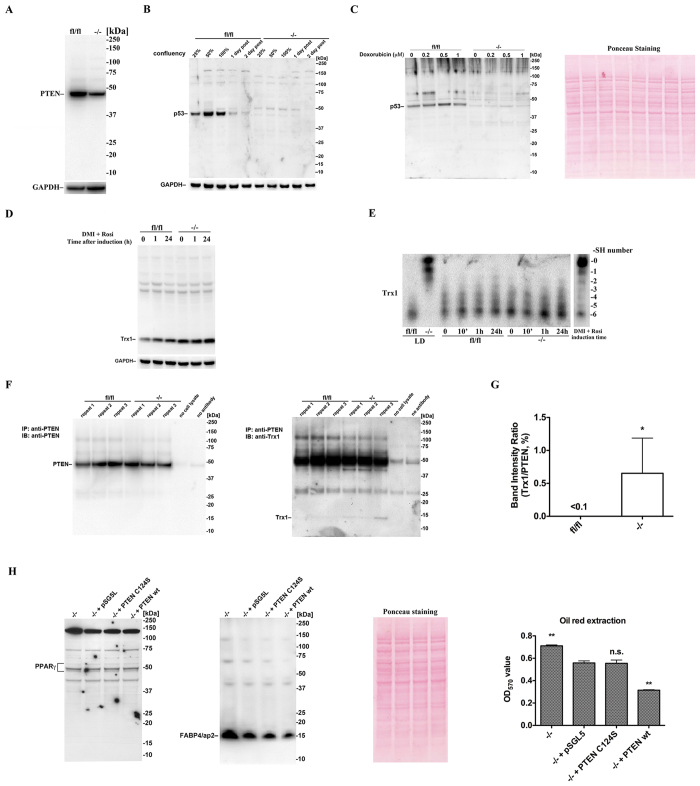
Attenuated cellular PTEN activity contributes to insulin sensitization and adipogenesis in Txnrd1−/− MEFs.(A) Lysates of Txnrd1fl/fl and Txnrd1−/− MEFs were immunoblotted with an antibody against PTEN, using GAPDH as loading control. (B) Txnrd1fl/fl and Txnrd1−/− MEFs were cultured into different stages of confluency, and lysates were immunoblotted with an antibody against p53, using GAPDH as loading control. (C) Txnrd1fl/fl and Txnrd1−/− MEFs were cultured to 100% confluency and then treated 24 h with doxorubicin as indicated. Lysates were immunoblotted with an antibody against p53 using Ponceau S staining as loading control. (D) Txnrd1fl/fl and Txnrd1−/− MEFs were induced for hormonal adipocyte differentiation for the indicated time, and lysates were immunoblotted with an antibody against Trx1. (E) Txnrd1fl/fl and Txnrd1−/− MEFs were induced to adipocyte differentiation with time points as indicated and the redox state of Trx1 was analyzed by redox immunoblotting15. Lysates of Txnrd1fl/fl and Txnrd1−/− MEFs cultured at low density (LD, 1000 cells/cm2) for 20 h in high glucose medium15 were used as negative and positive controls for Trx1 oxidation, respectively. Migration of Trx1 in a standard curve of MEF lysate treated so that Trx1 variants in all forms from 0 to 6 free Cys thiol (-SH) groups being present70 is shown in the last lane. (F) Lysates of Txnrd1fl/fl and Txnrd1−/− MEFs were immunoprecipitated with an antibody against PTEN and then immunoblotted with an antibody against either PTEN (left) or Trx1 (right), with three repeats for each cell line or controls without cell lysate or antibody against PTEN as indicated. (G) Band intensities in F were quantified with the ratio between Trx1 and PTEN plotted (n = 3, ±SEM) and significant difference indicated (*P < 0.05). (H) Confluent Txnrd1−/− MEFs transfected for expression of PTEN variants as indicated were induced with adipocyte differentiation treatment. Lysates were subsequently immunoblotted with antibodies against PPARγ or FABP4/aP2, with Ponceau S staining as loading control. Oil Red-O staining after differentiation was also extracted with color intensity measured (n = 4–8, ±SEM). Significant differences against cells transfected with empty vector pSG5L are indicated (n.s. no significant difference; **P < 0.01).